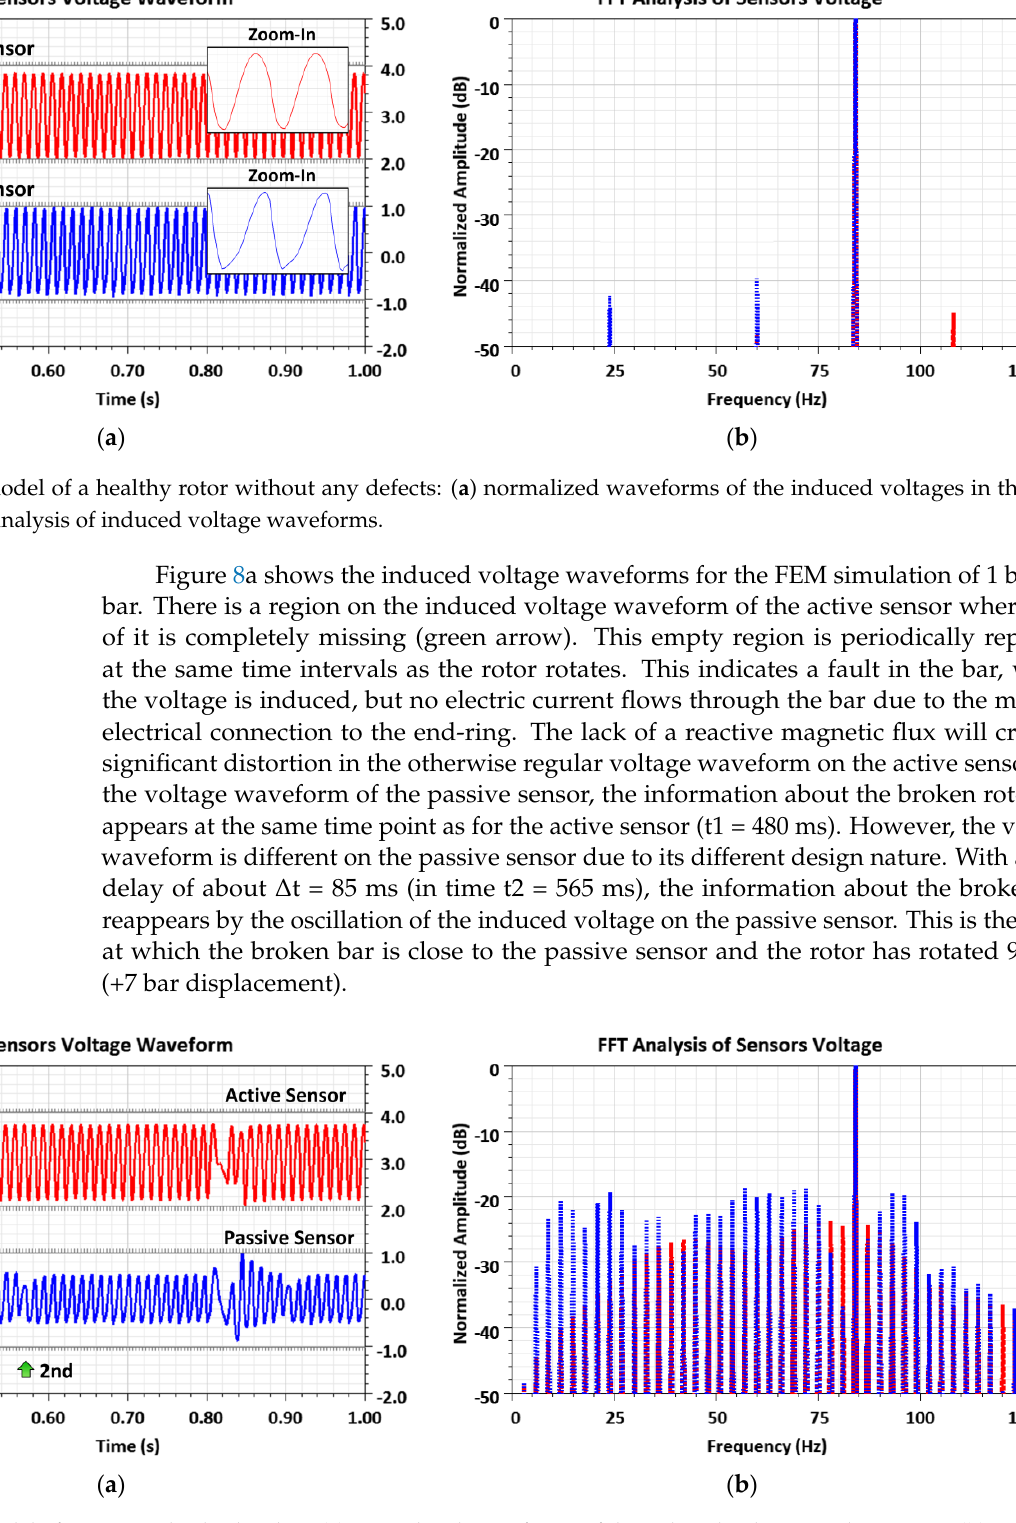
( b ) Figure 9. FEM model of a rotor with a broken end-ring segment: ( a ) normalized waveforms of the induced voltages in the sensors; ( b ) FFT analysis of induced voltage waveforms. A segment failure is repeatedly visible on the induced voltage waveform of the passive sensor, similar to the case of a broken bar. The information about the faulty segment is at the same time instant as for the active sensor (t1 = 480 ms). It appears as an oscillation and a significant waveform distortion. Then, the amplitude of the oscillation decreases and then slowly increases until the faulty segment (2 adjacent bars with a faulty segment) is close to the passive sensor. Here again, the amplitude of the induced